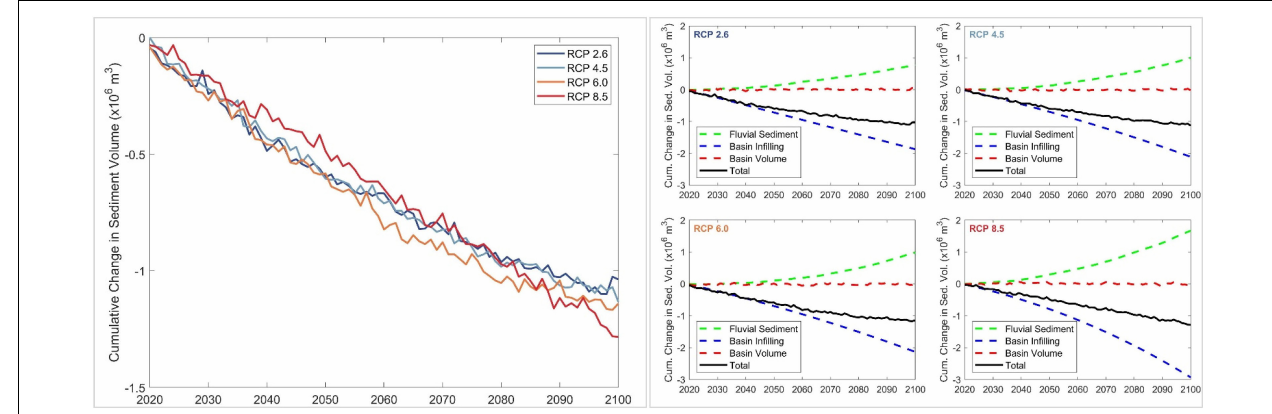
FIGURE 7 | Projected change in total sediment volume exchange ( (cid:49) V T ) between the Alsea estuary and the adjacent coast (left) , and the relative contributions of the three different sediment volume components (right) over the 21 st century for RCP 2.6, 4.5, 6.0, and 8.5. Negative and positive values of (cid:49) V T indicate sediment imported to the estuary from the adjacent coast and sediment exported from the estuary to the adjacent coast, respectively.